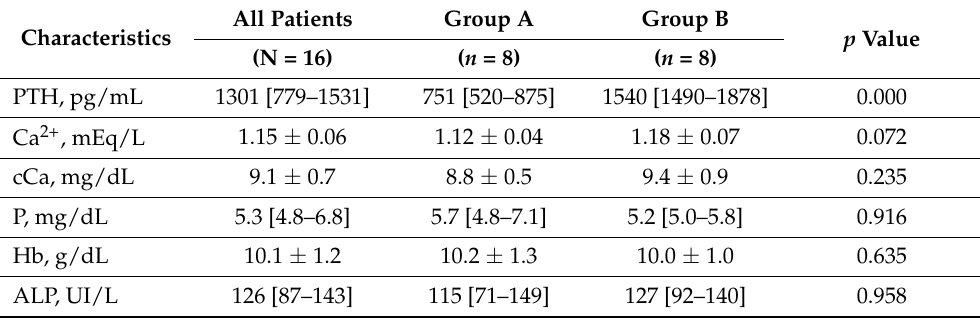
Table 2. Baseline values of the biochemical parameters evaluated in the study. Abbreviations: PTH, parathyroid hormone; Ca 2+ , ionized calcium; cCa, total serum calcium corrected for albumin values; P, phosphorus; Hb, hemoglobin; ALP, alkaline phosphatase. Values are expressed as mean ± standard deviation or, in case of non-Gaussian distribution, as median [interquartile